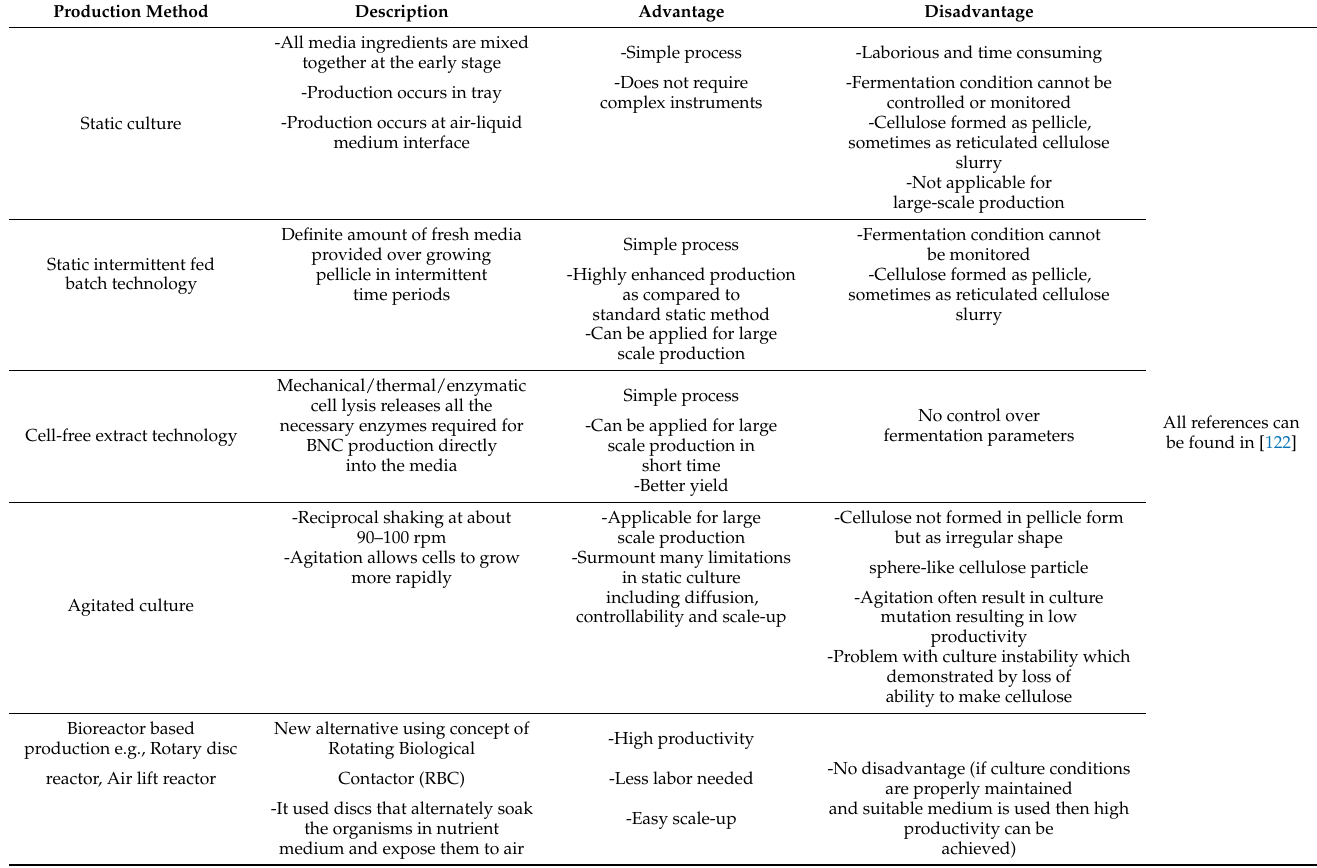
Table 4. BC Cultivation approaches. Adapted with permission from